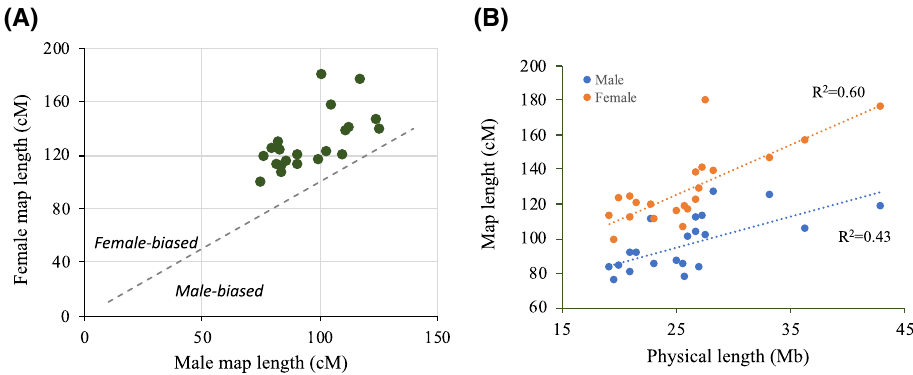
Figure 4. Comparison of male and female genetic maps. ( A ) Male vs female linkage groups lengths (cM) for the 21 Senegalese sole chromosomes. All chromosomes exhibit female-biased recombination. ( B ) Correlation between recombination map and physical map lengths in both males (blue) and females (orange). The determination coefficient R 2 is shown separately for each sex.